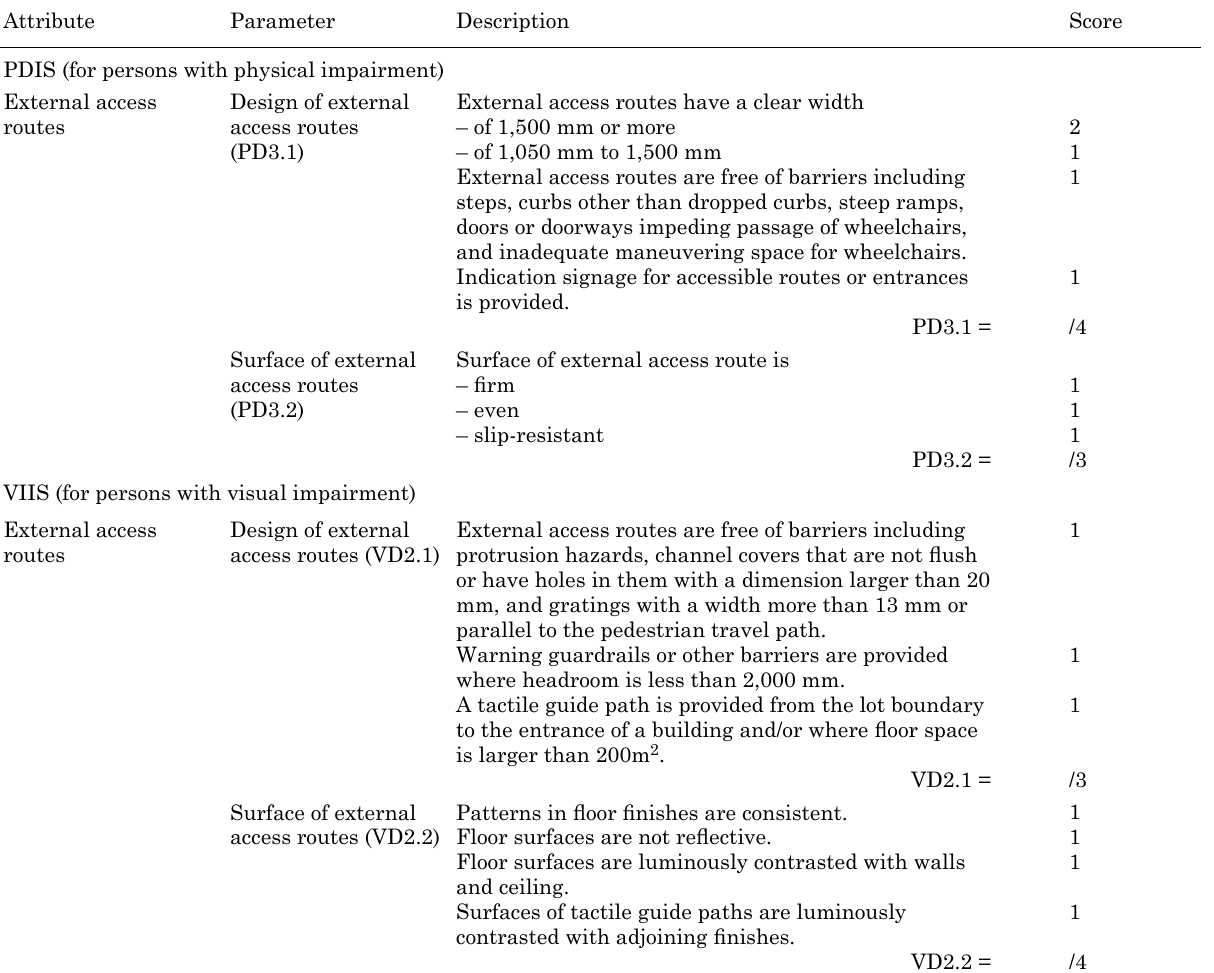
Table 3. Examples of PDIS and VIIS rating